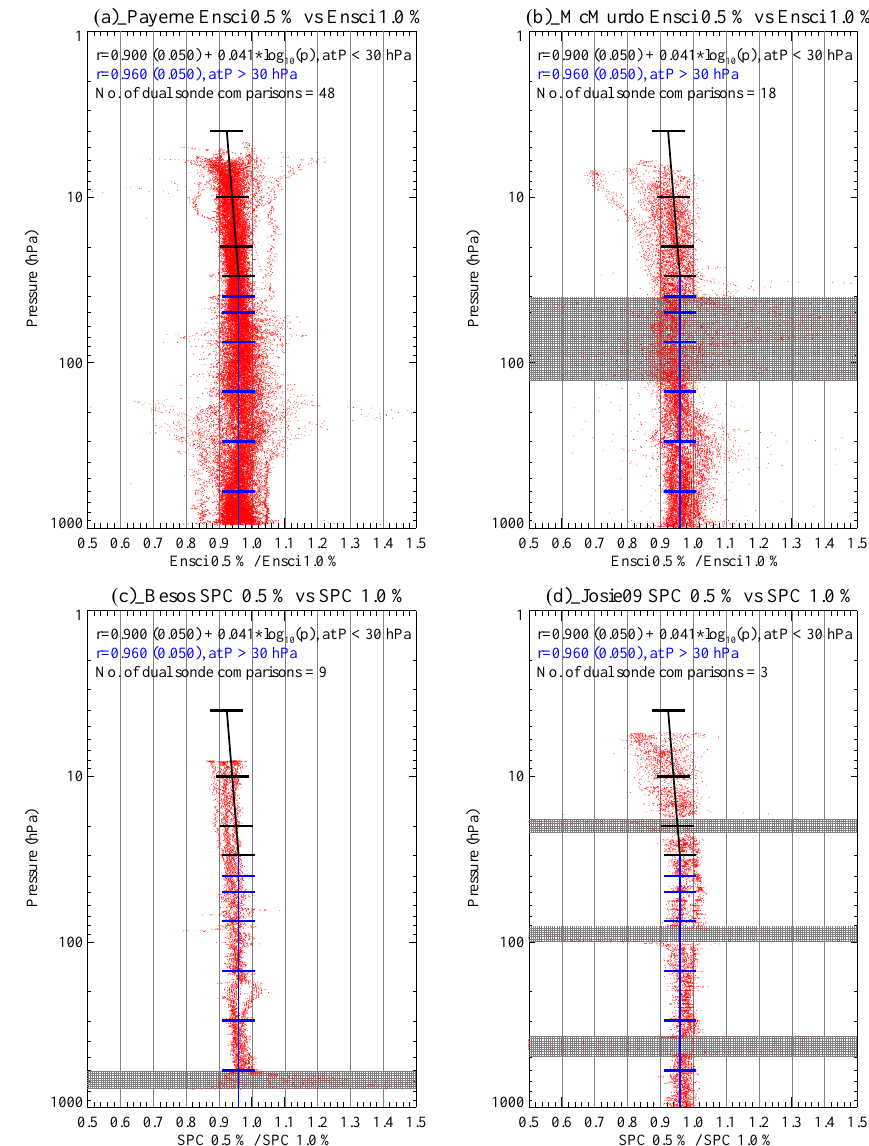
Figure 6. Vertical profiles of ratios of ozone partial pressure using ozonesondes with different KI concentrations (0.5, 1.0%) in ozonesondes of the same manufacturer, EN or SP. (a) Payerne – EN; (b) McMurdo – EN; (c) BESOS – SP; and (d) JOSIE09 – SP. The hashed areas are regions of low ozone concentration in ozone hole measurements, McMurdo; tests in the laboratory, JOSIE09; or during initial problems with the BESOS data system at the lowest altitudes. Fits to the data using the transfer functions from Eq. (5), and included at the top of each panel, are shown in blue and black. The numbers in parantheses behind each slope are the uncertainties of the fit. OZ 0 . 5%